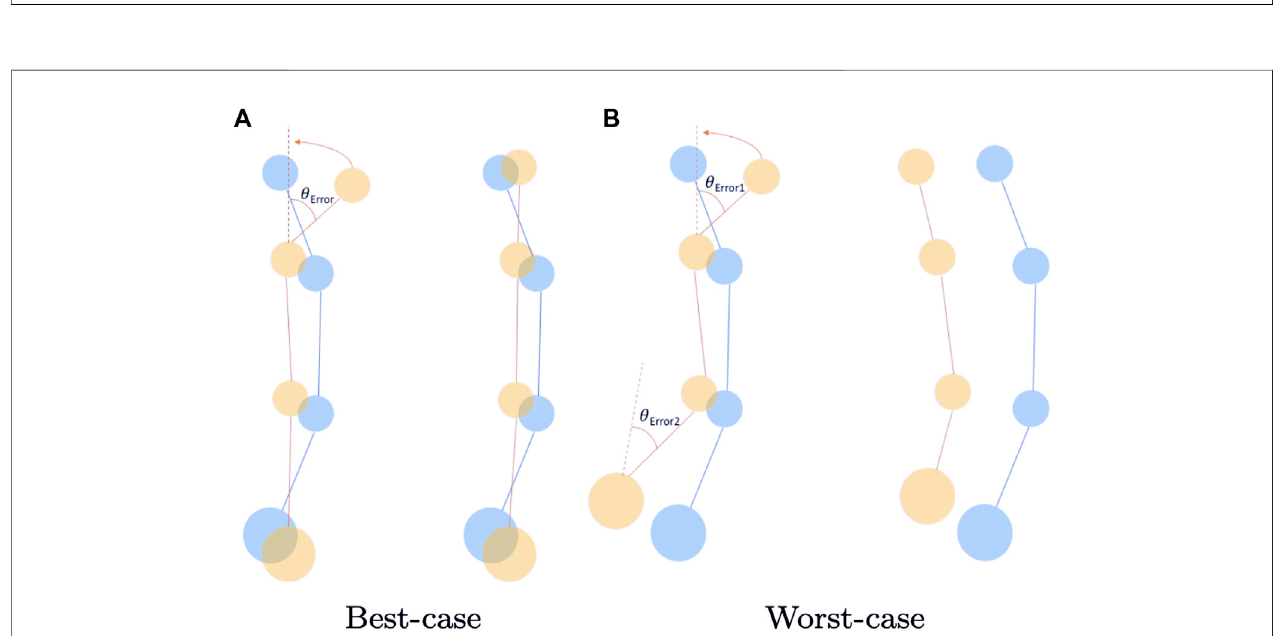
FIGURE8| Simple2Dillustrationforthebest-caseandworst-casecorrectionsperformedbytheanatomical fi lter. (A) showsthebest-casescenarioand (B) shows the worst-case scenario. The blue circles indicate joint locations of a single index fi nger from the ground truth. The yellow circles indicate the position of the estimated joints from the hand tracker.